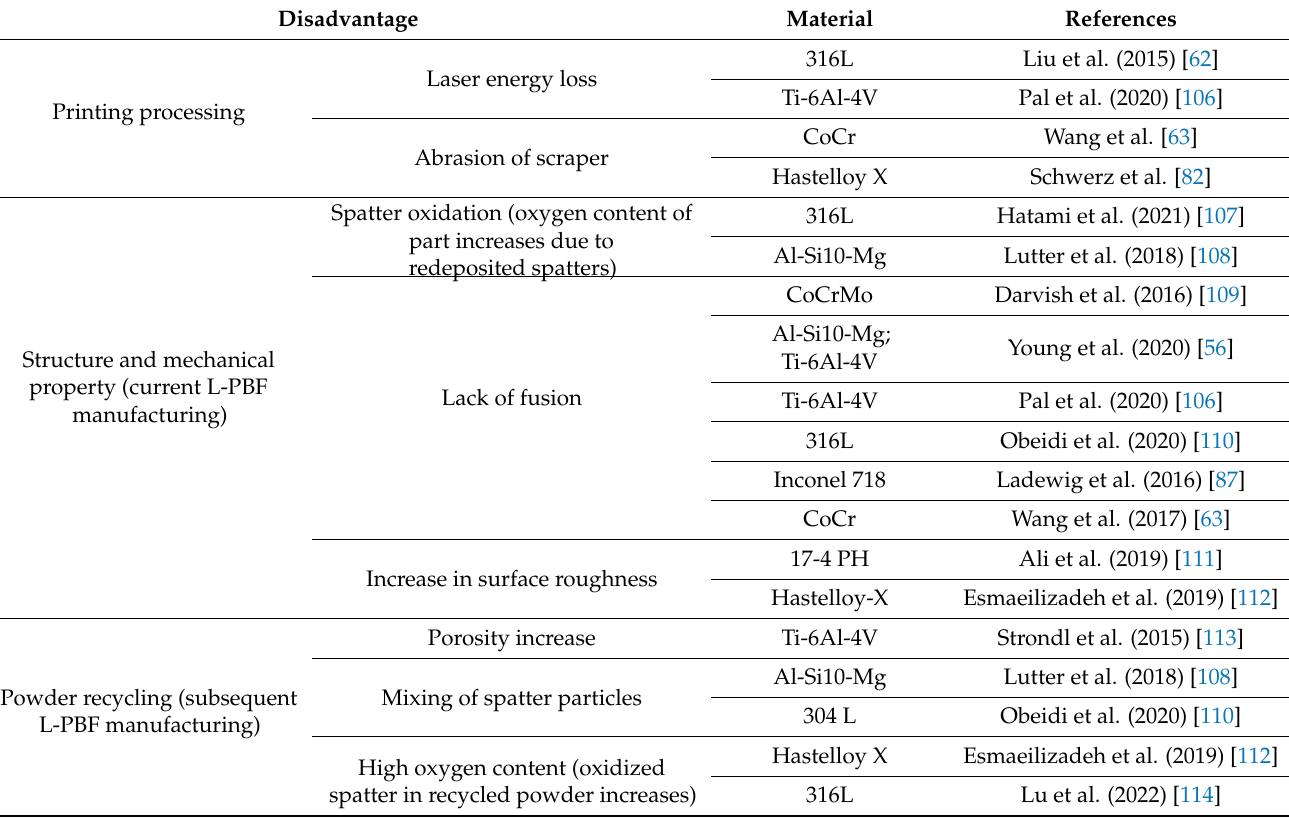
Table 8. Summary of studies on the disadvantages of